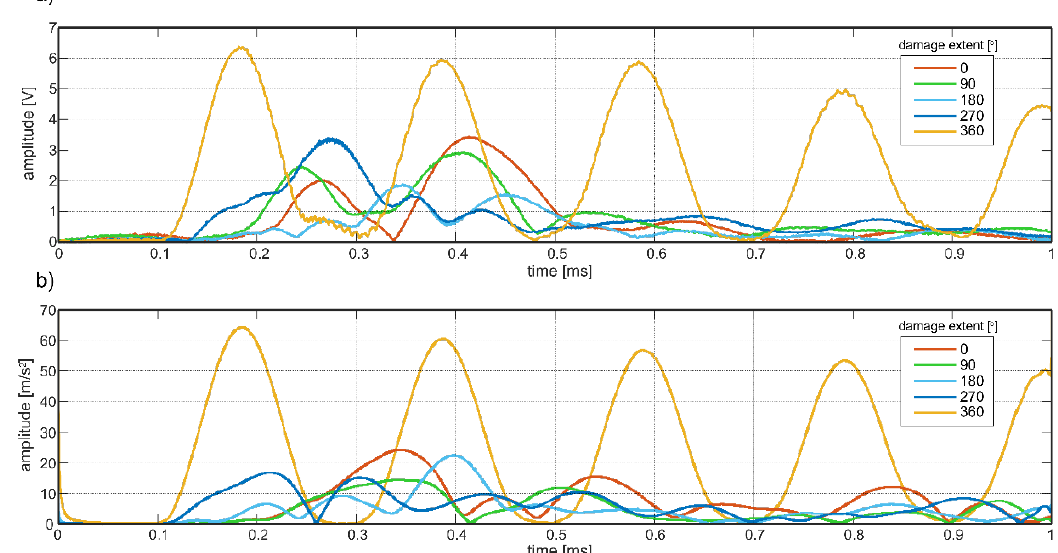
Figure 14. Envelopes of signals obtained ( a ) experimentally and ( b ) numerically for varying extent of debonding.